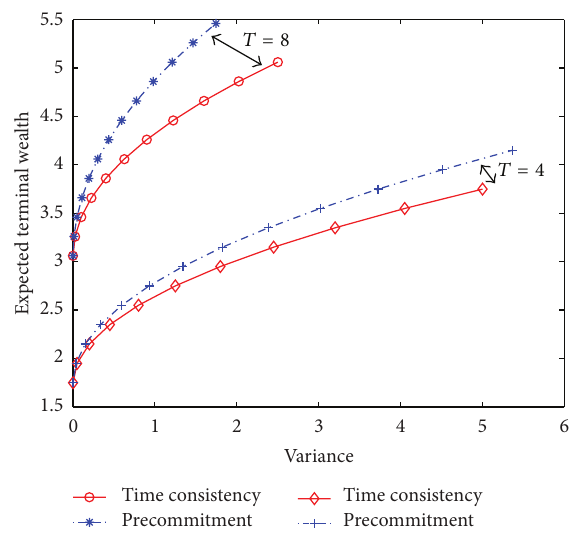
Figure 3: Efficient